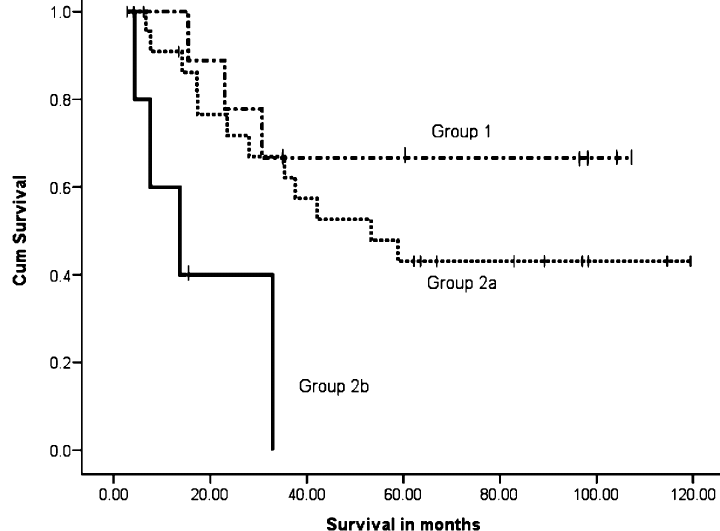
Fig. 3. Kaplan–Meyer curves of clusters 1, 2a and 2b. Cumulative survival is shown in relation to time in months. Group 1 ( N = 8) are OOSCC with hardly any chromosomal aberrations; group 2 contains the OOSCC with a relatively high level of chromosomal aberrations, divided in b ( N = 5) with the highest and a ( N = 26) with a lower level of aberrations. Log-rank analysis yielded a p -value of